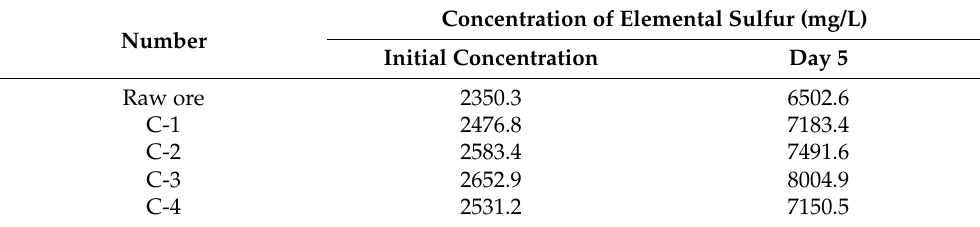
Table 12. Results of the experiment on the effect of ultrasonic power on desulfurization